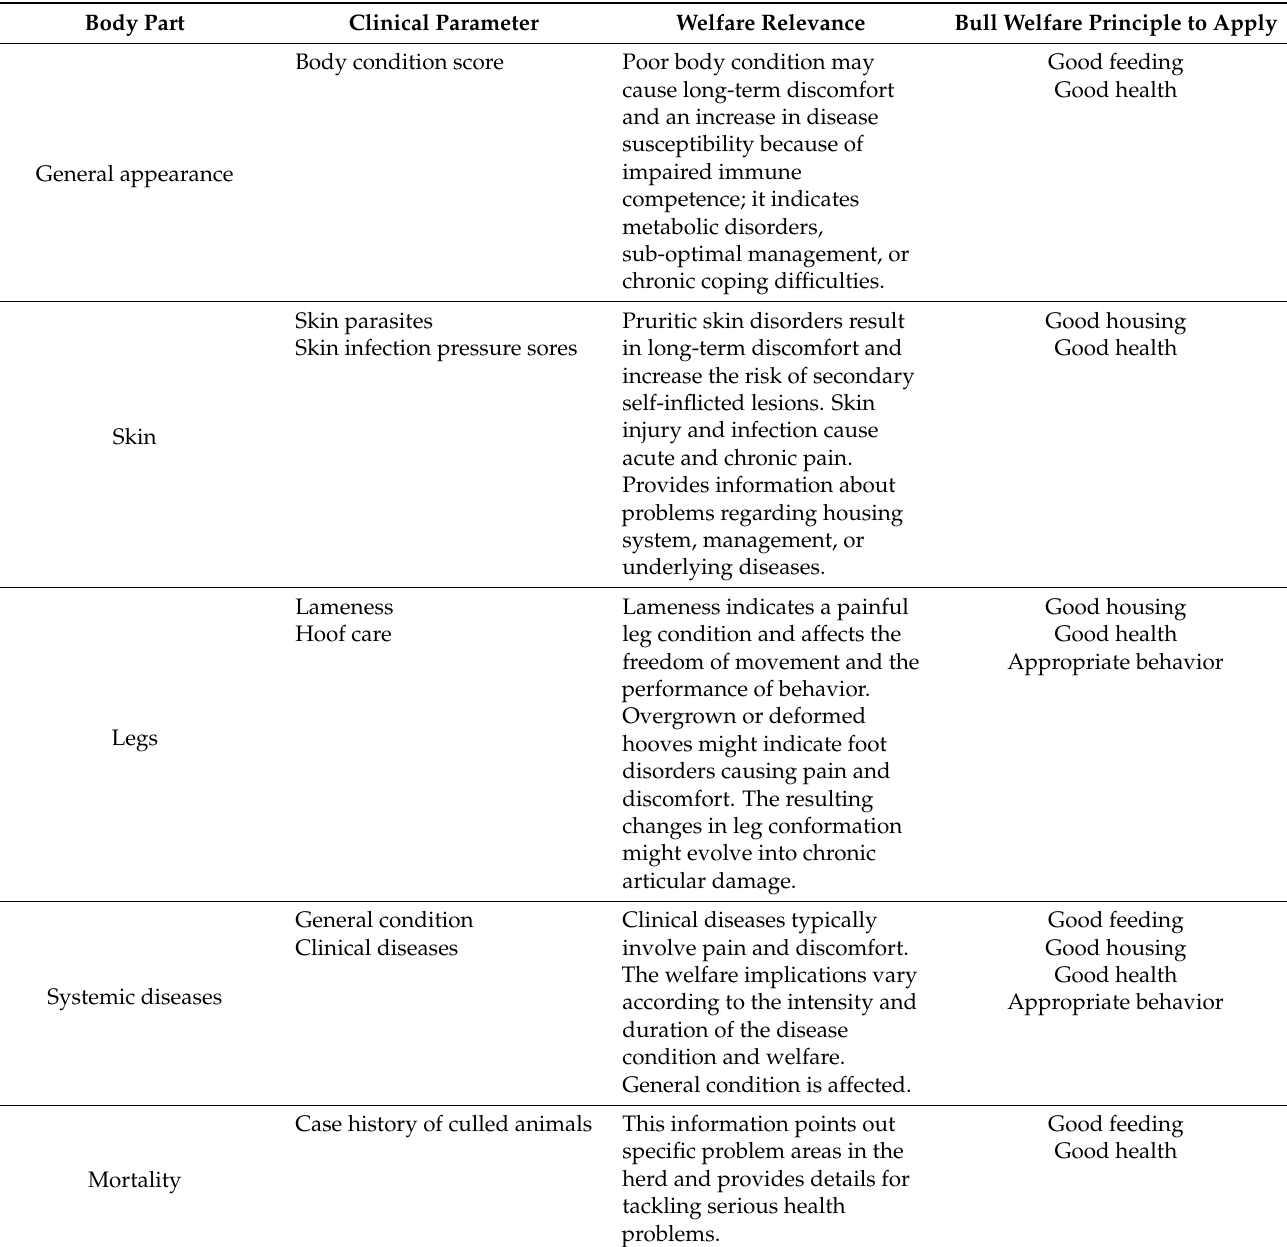
Table 1. Health indicators, which might be included in bull welfare assessment (modified from Rousing et al.